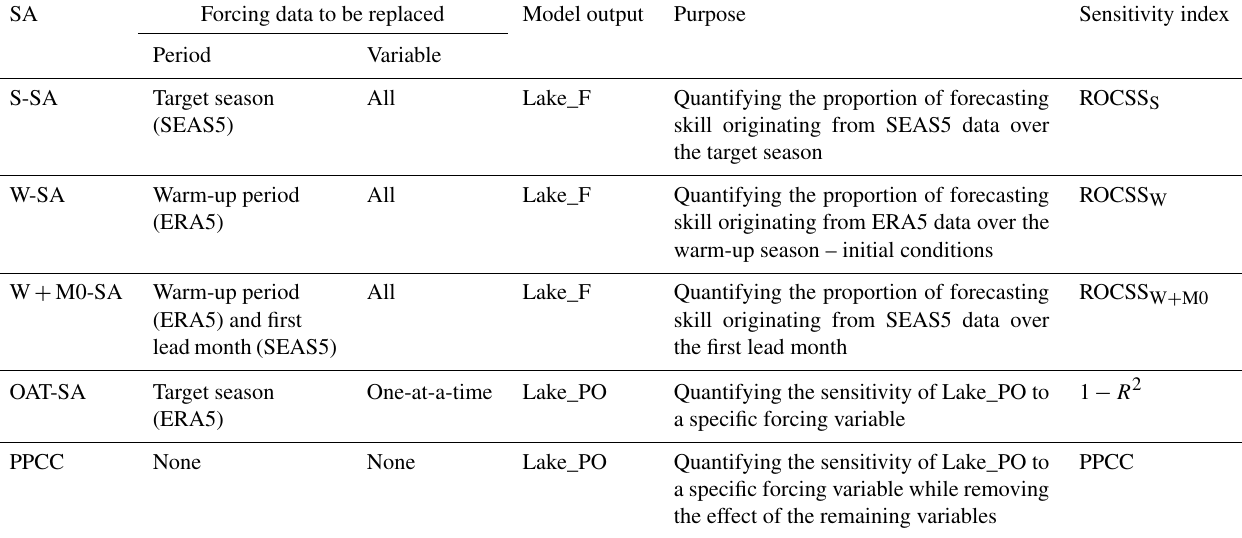
ROCSS S ROCSS W ROCSS W + M0 1 − R 2